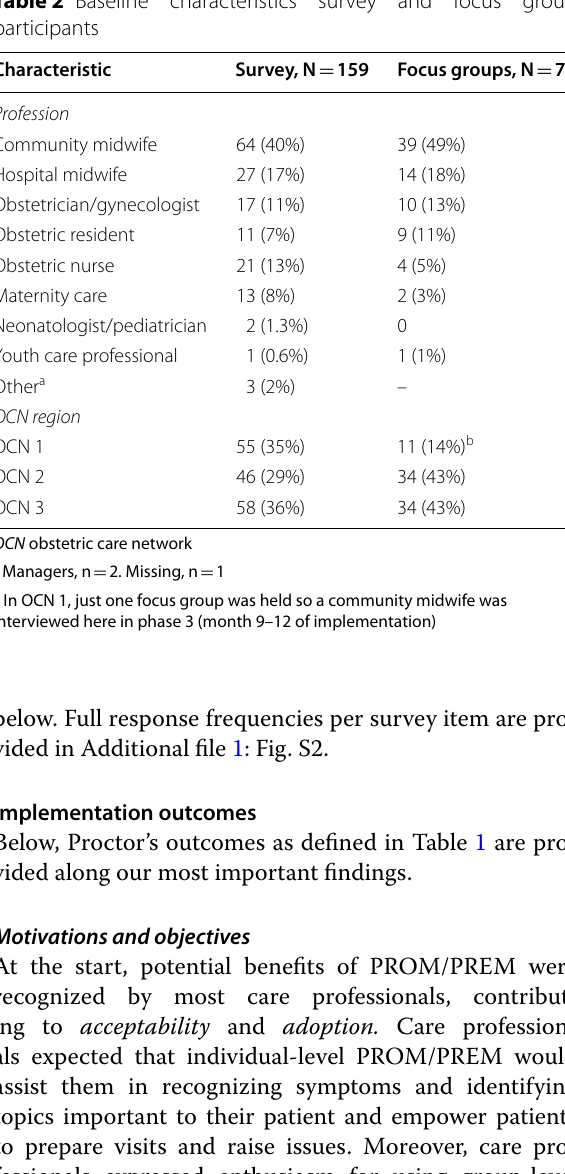
Table 2 Baseline characteristics survey and focus